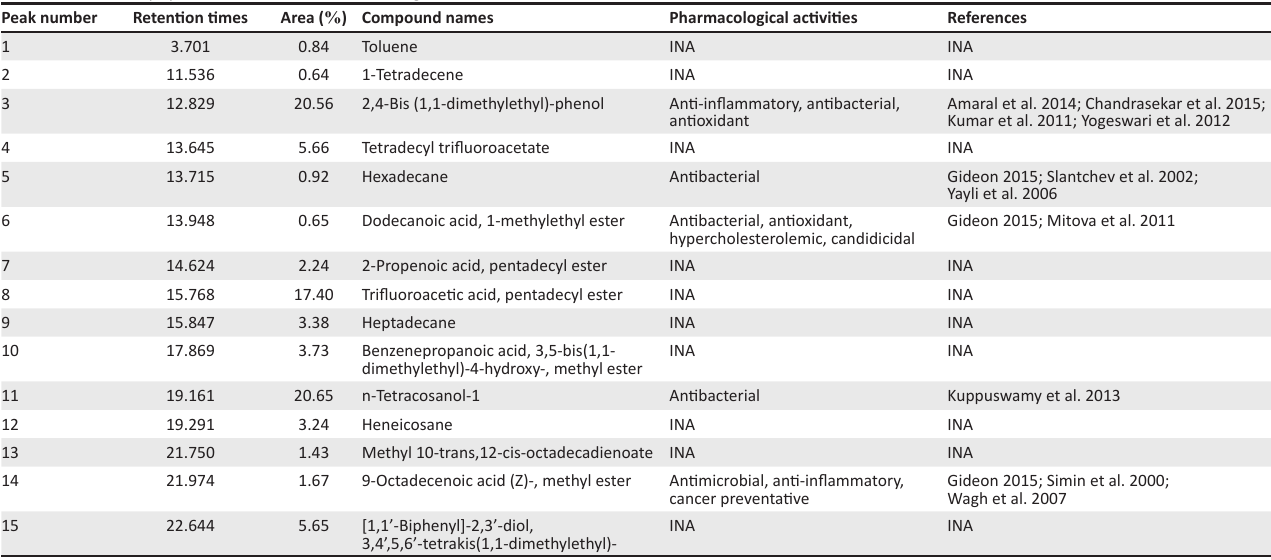
TABLE 5: Identified phytoconstituents in the chromatogram of subfraction 9. Peak number Retention times Area ( % ) Compound names